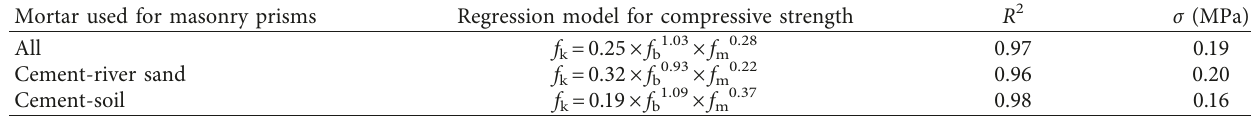
Table 7: Equation proposed for the estimation of stabilized earth block masonry compressive strength. Mortar used for masonry prisms Regression model for compressive strength